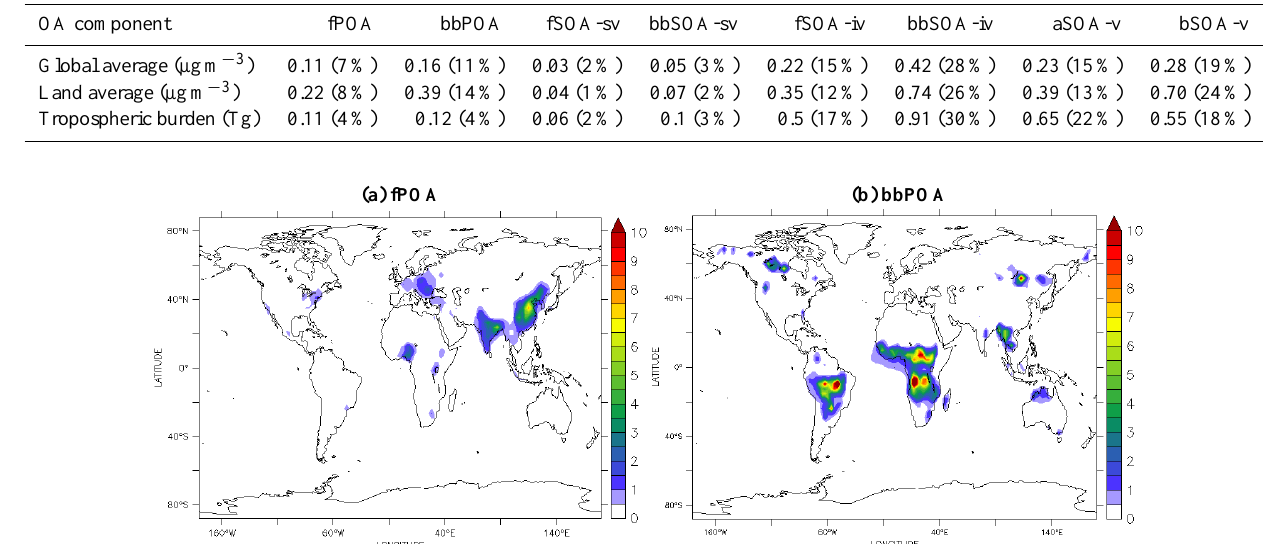
Figure 5: Modeled average surface concentrations (in μg m -3 ) of (a) POA from fuel combustion 1229 Figure 5. Modeled average surface concentrations (in µgm − 3 ) of (a) POA from fuel combustion (fPOA) and (b) POA from biomass burning (fPOA) and (b) POA from biomass burning emissions (bbPOA) during the years 2005-2009. 1230 emissions (bbPOA) during the years